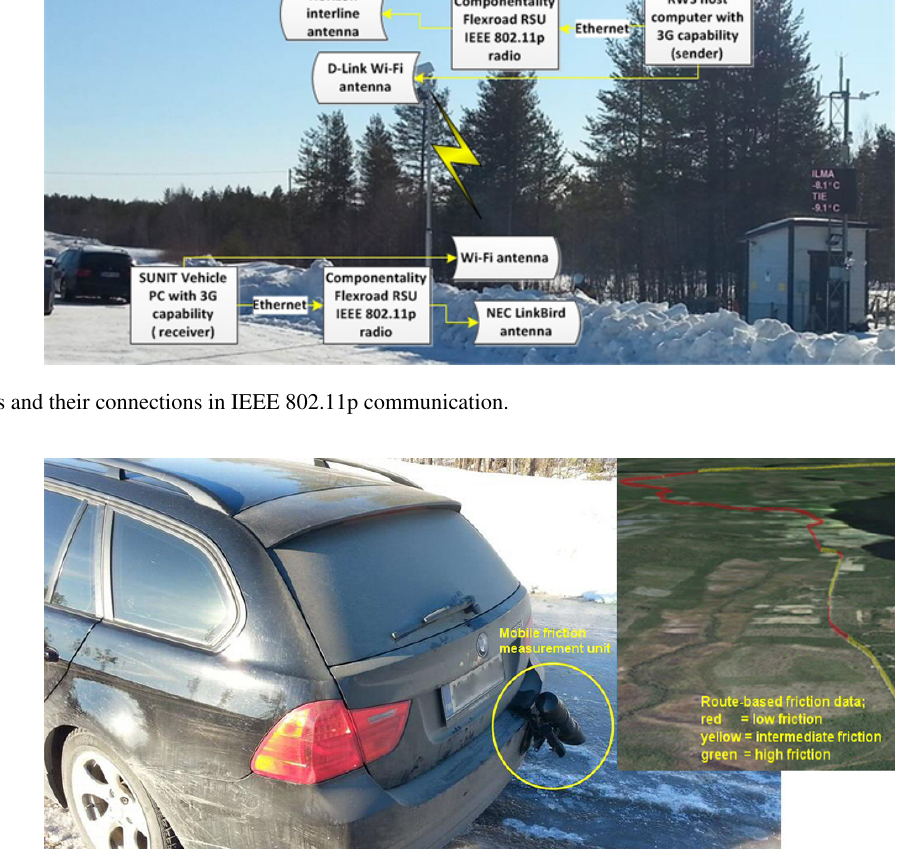
pushing an emergency button in the vehicle computer unit, to be later on integrated into the vehicle’s internal systems. The friction measurements and telematics data represent more so- phisticated vehicle